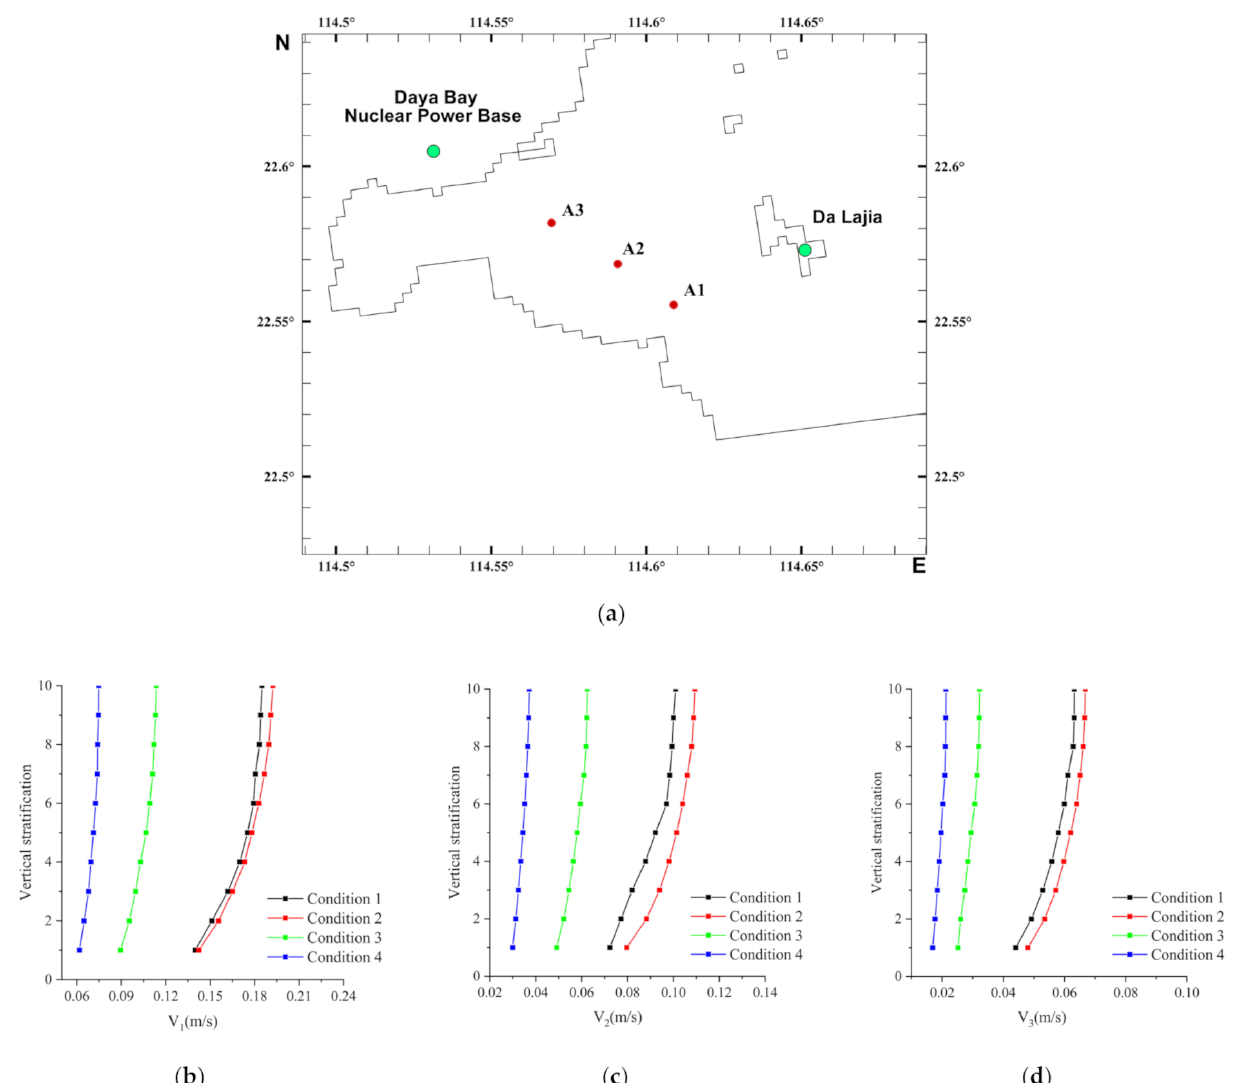
Figure 6. Velocity distribution in vertical direction at each characteristic point: ( a ) typical location to show velocity; ( b ) magnitude of vertical stratified flow velocity at point A1; ( c ) velocity at point A2; ( d ) velocity at point A3. (Condition 1: the moment when the rising tide flows fastest; Condition 2: the moment when the falling tide flows fastest; Condition 3: the moment when the tide is at its lowest and the water level is stable; Condition 4: the moment when the tide is at its highest and the water level is